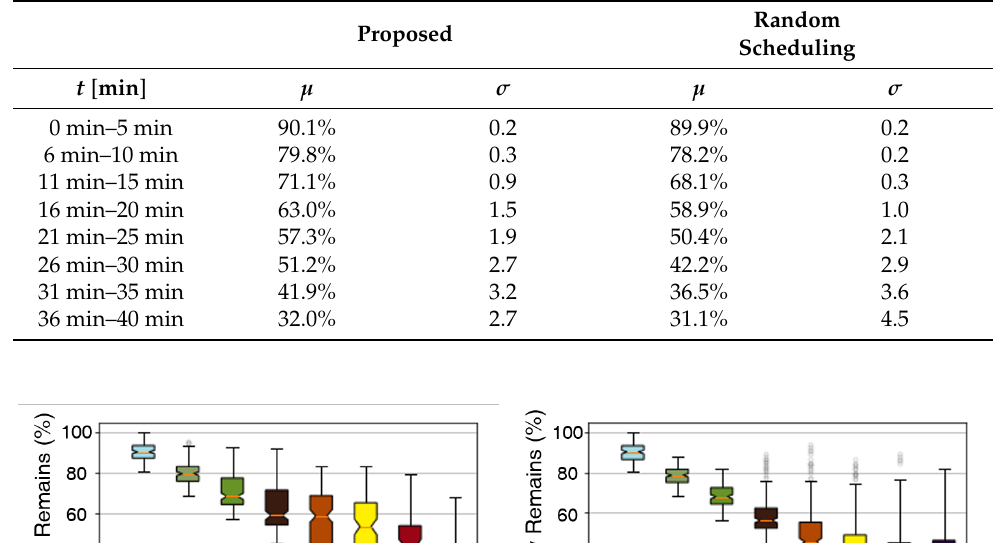
Table 2. Residual battery/energy amounts of unmanned aerial vehicles (UAVs) (unit: percentage) for both of the Proposed algorithm and the Random Scheduling algorithm, where µ and σ stand for the average and variance of UAV battery/energy remains. Random Proposed Scheduling